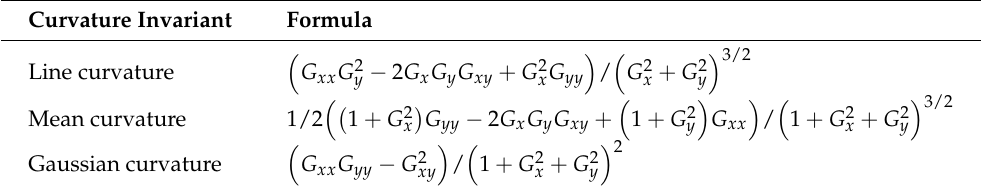
Table 2. Curvature invariants.